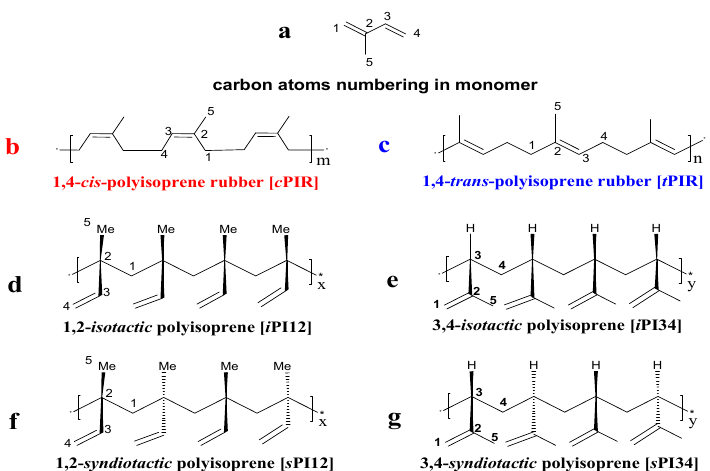
Scheme 2. Carbon atoms numbering in IP monomer and in different PIR macromolecular chains: